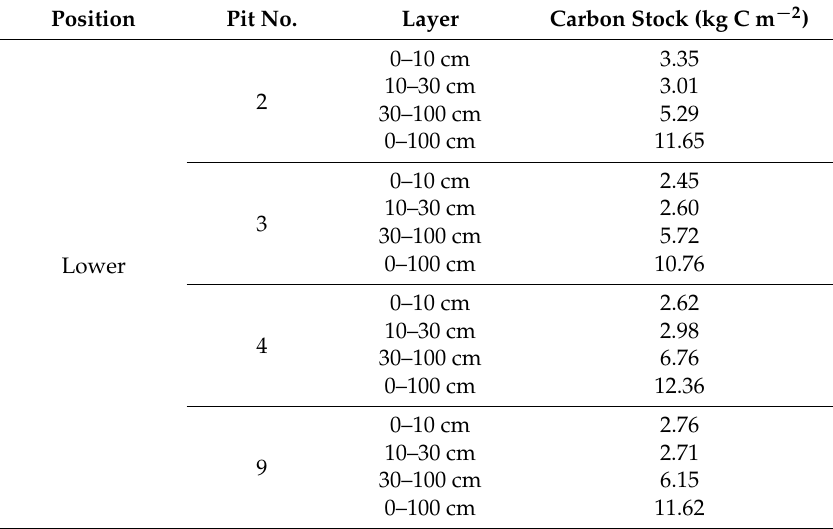
Table A2. Soil carbon stocks in the surveyed soil pits. Soil pit numbers refer to those indicated in the map shown in Figure